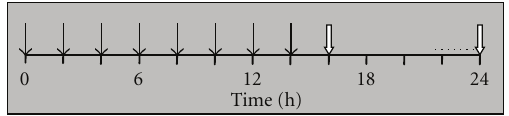
Figure 1: A diagram of daily CDFF regime for 8 days. On each day, a DMM supply (solid horizontal line) was interrupted by eight 2-hourly 5 min sucrose pulses (black arrows) and two 10 min treatments (white arrows). The treatments occurred 2 h after the last sucrose pulse and 20 min before the end of the “resting period” (DMM supply for 10 h). Dashed horizontal line indicates the sampling time on day